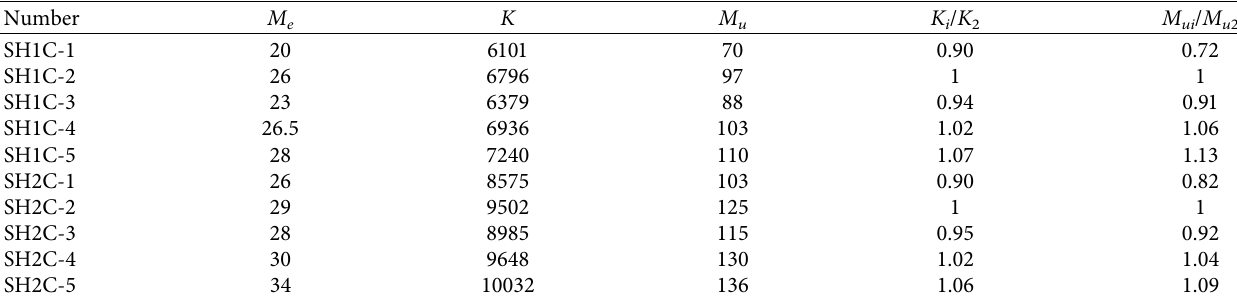
Figure 20: Bending moment-rotation curves of different thicknesses and widths of the connection angle. (a) Series of beam H1. (b) Series of beam H2. Table 9: Joint properties of angle steel with different thicknesses and widths of the connection